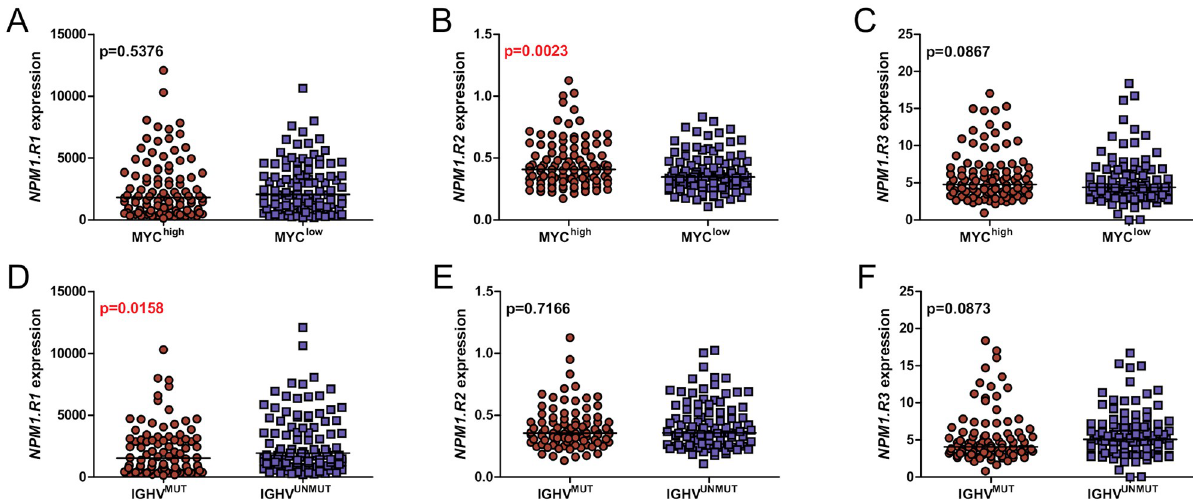
Fig 2. The expression of NPM1 splicing variants and their correlation with MYC level and the IGHV mutation status. (A-C) The comparison of three NPM1 transcripts levels in CLL samples, according to the MYC expression level (D-F) and the IGHV mutation status. Each dot represents one sample. Mann-Whitney p values are included. Red color indicates statistically significant p